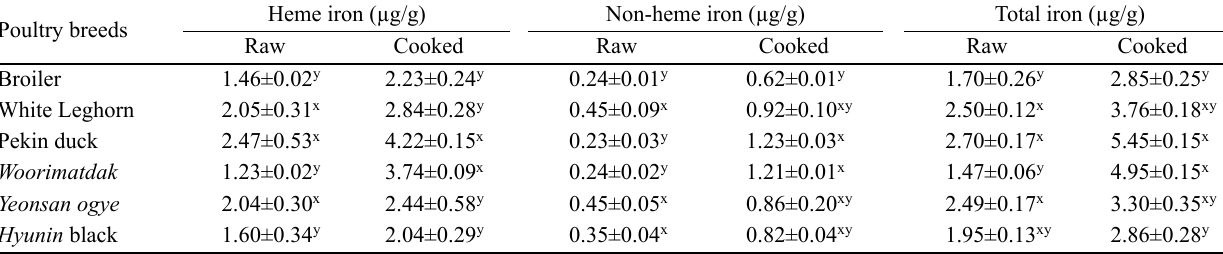
Table 4. Iron contents of raw and cooked thigh meat of different breeds of poultry Heme iron (µg/g) Non-heme iron (µg/g) Poultry breeds Cooked Raw Cooked Raw